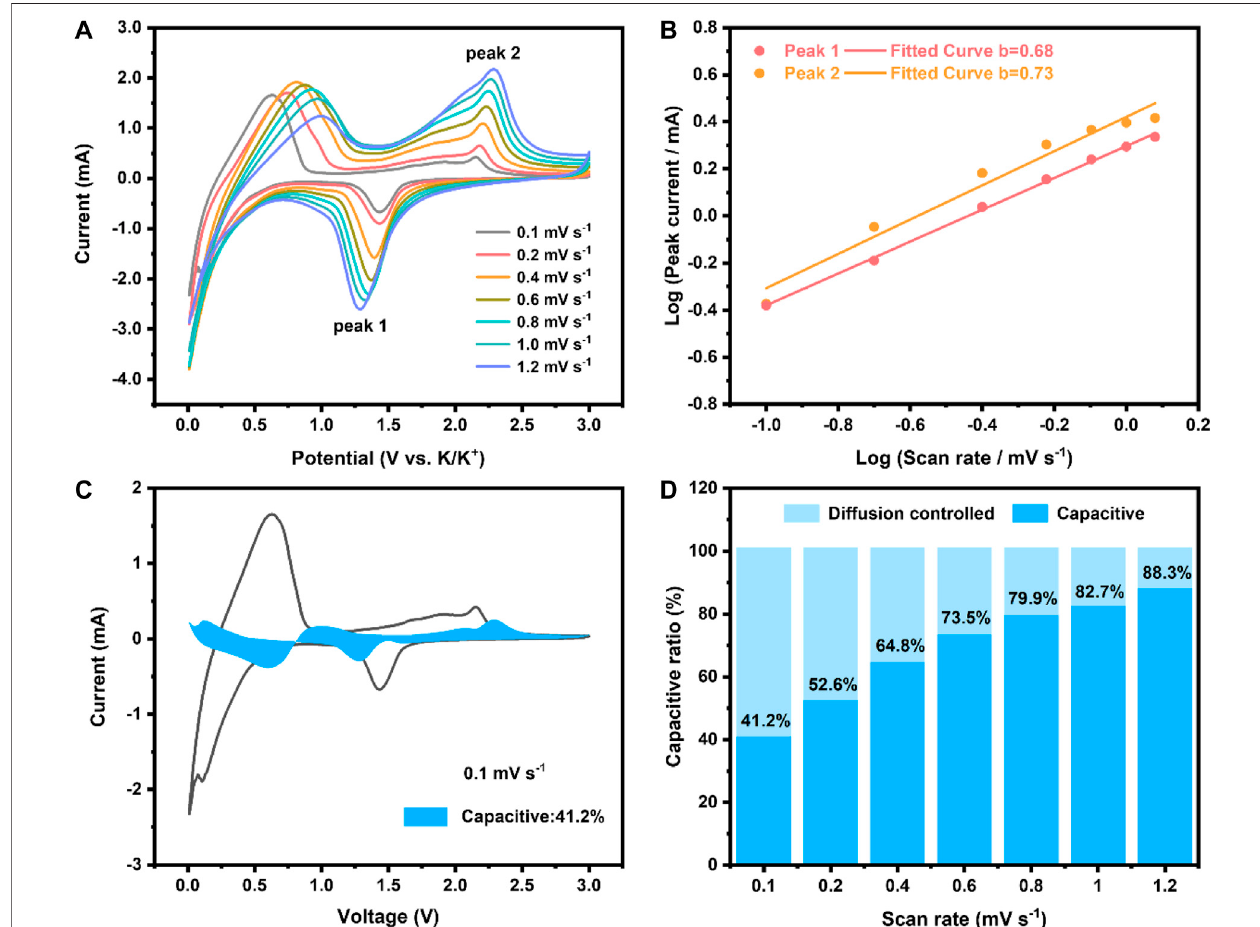
FIGURE5|(A) CVcurvesoftheNiCo 2 Se 4 ⊂ SPNC/CC anode atdifferentscanrates, (B) Plots forb-value determination, (C) Sketchviewofthecapacitivebehavior of the NiCo 2 Se 4 ⊂ SPNC/CC anode at 1.0 mV s − 1 , and (D) Contribution rate of pseudocapacitance and diffusion control at different scan rates.